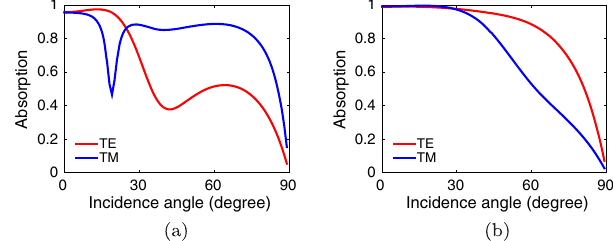
FIG. 8. The absorption level A ¼ 1 − R − T in a metasurface with (a) single-turn and (b) double-turn helical elements versus the incident